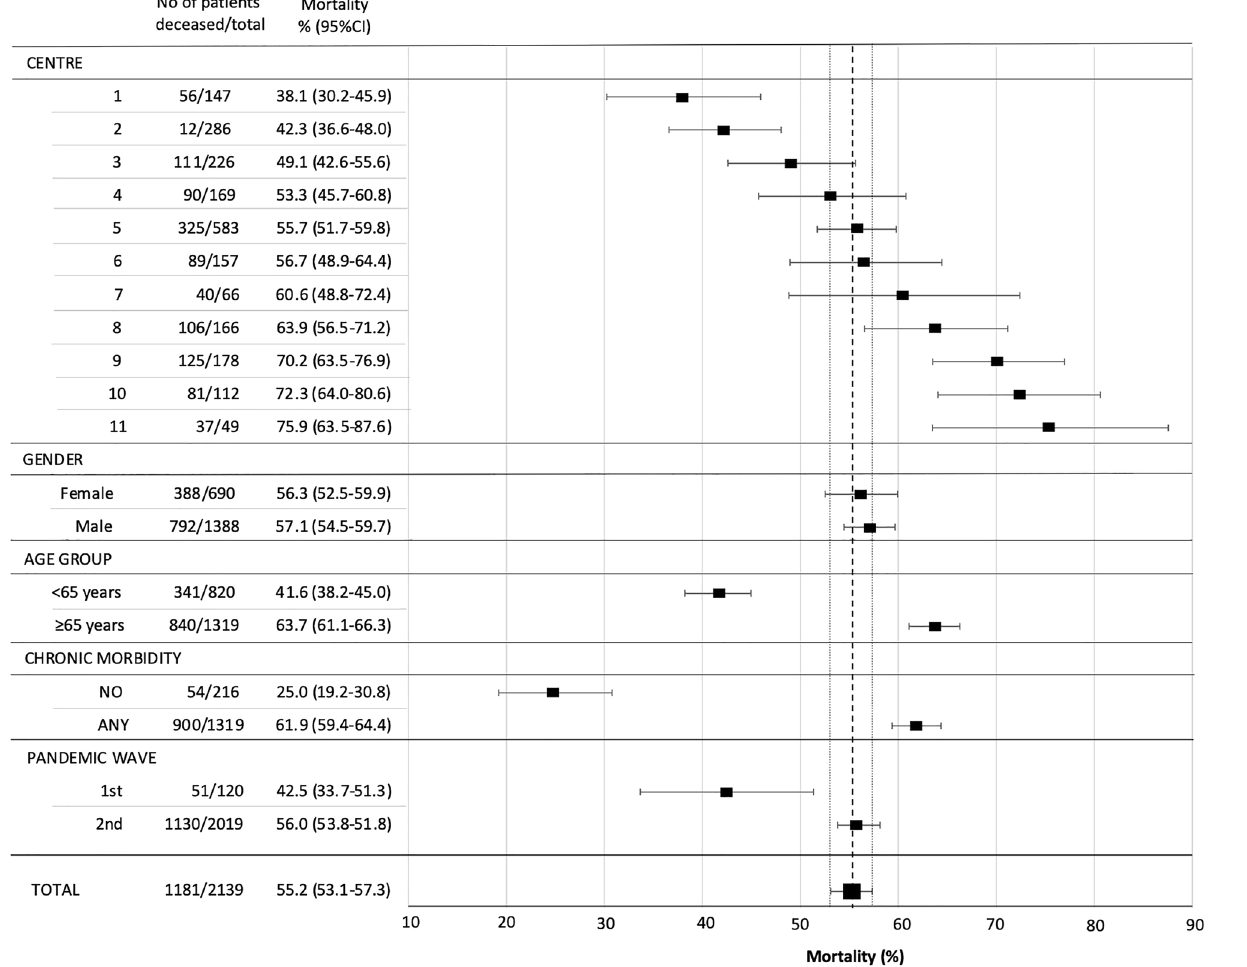
Figure 1. Hospital mortality in selected subgroups as compared to the overall cohort. Mortality is expressed in percentages and depicted as squares. Corresponding 95% confidence intervals (95% CI) are given in parentheses and shown as error bars. Dashed and dotted vertical lines represent mortality and boundaries of 95% CI in the overall cohort,